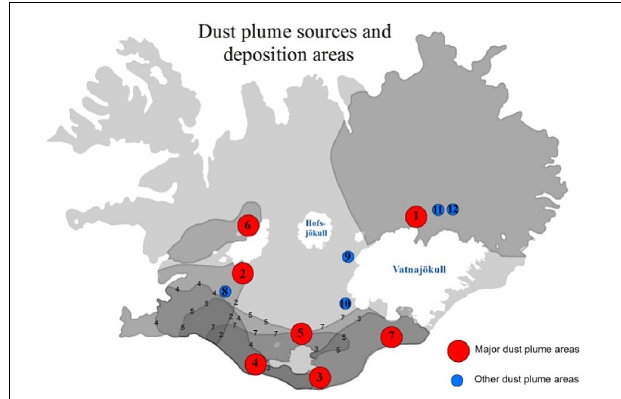
FIGURE 2 | Major dust plume sources and estimated regions of deposition (Arnalds, 2010): (1) Dyngjusandur, (2) Hagavatn, (3) Mýrdalssandur, (4) Landeyjasandur, (5) Mælifellssandur, (6) Flosaskarð, (7) Skeiðarársandur.